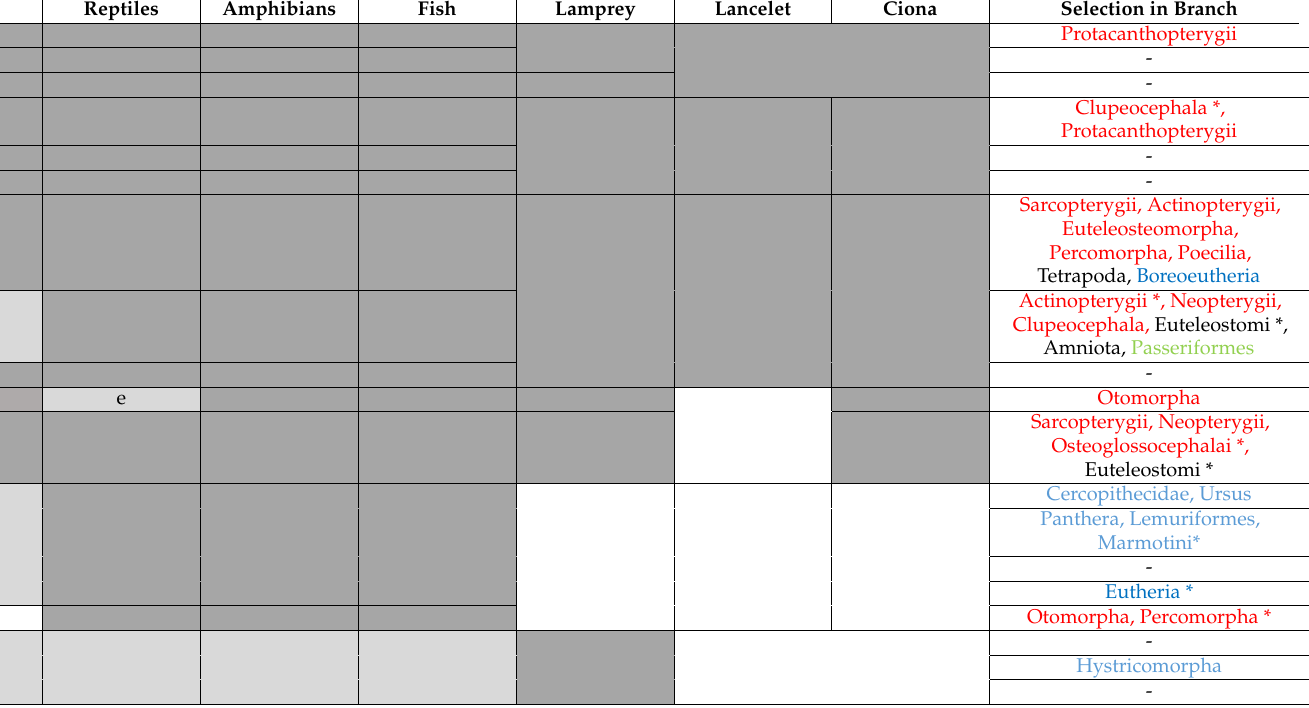
Table 1. Presence of aGPCRs in Chordata and signatures of positive selection in branches. The presence of individual aGPCR members are depicted in dark grey. In case some animal orders lack the individual member, boxes are in light grey. Furthermore, some species lack a clear one-to-one orthology to a human aGPCR member. In such a case, the box spans over more than one human aGPCR. For example, in lamprey there are two members of the family A, but one member has similar identities to the human ADGRA1 and ADGRA3. The complete absence of a member is shown in white boxes. For selection analysis the webtool Selectome (https://selectome.org/; accessed on 15 August 2021) with the default aGPCR ortholog alignments and phylogenetic trees was used [29]. This analysis uses the branch-site model to determine ω -values among branches. The assigned significance of the detection of positive selection on the selected branch can be extracted with the webtool by entering the respective aGPCR gene name. Branches with significant signatures of positive selection are given in black for major branches, in red for fishes, in green for birds and reptiles, and in blue for mammals. Branches marked with * underwent duplication and positive